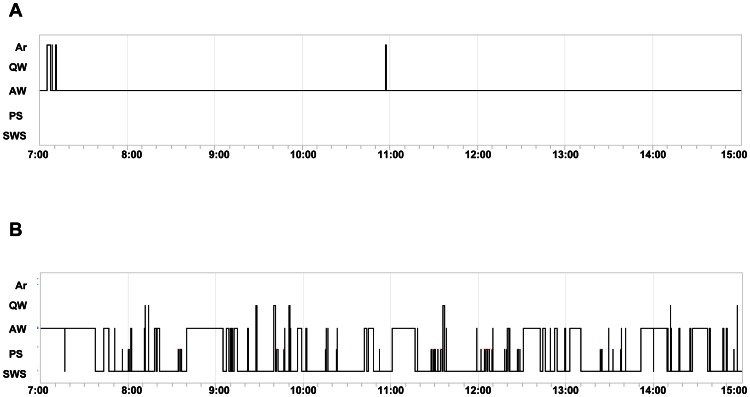
Hypnograms recorded during A) 8 h of SD period and B) corresponding 8 h of control period by electroencephalography.Ar = artifact, QW = quiet wake, AW = active wake, PS = paradoxical sleep, SWS = slow wave sleep.